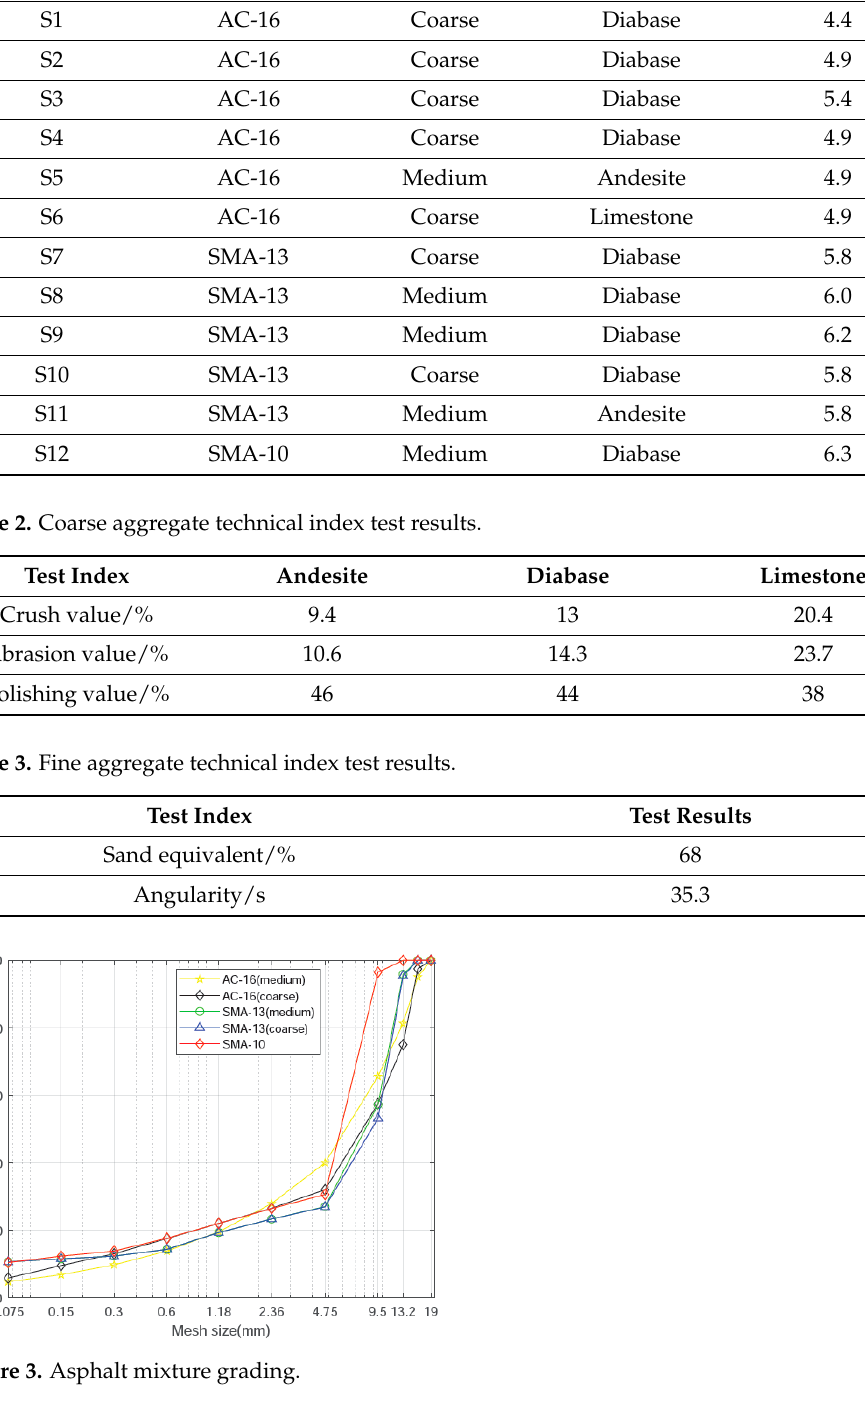
Table 1. Experiment plan.